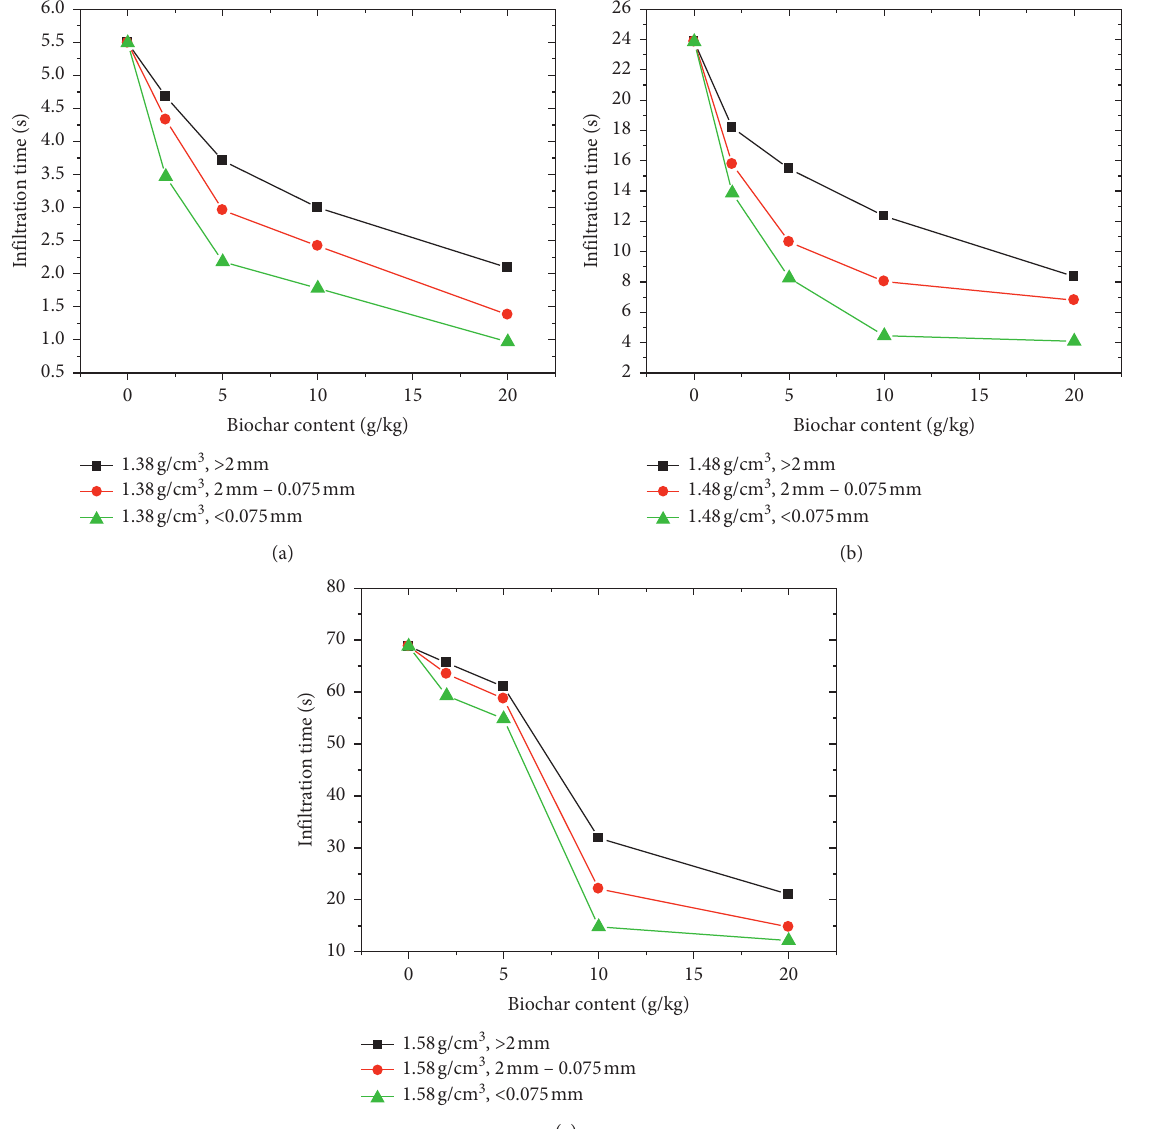
Figure 3: The variation of soil infiltration time with the amount of biochar (a) for ρ � 1.38g/cm 3 , (b) for ρ � 1.48g/cm 3 , and (c) for ρ � 1.58g/ cm 3